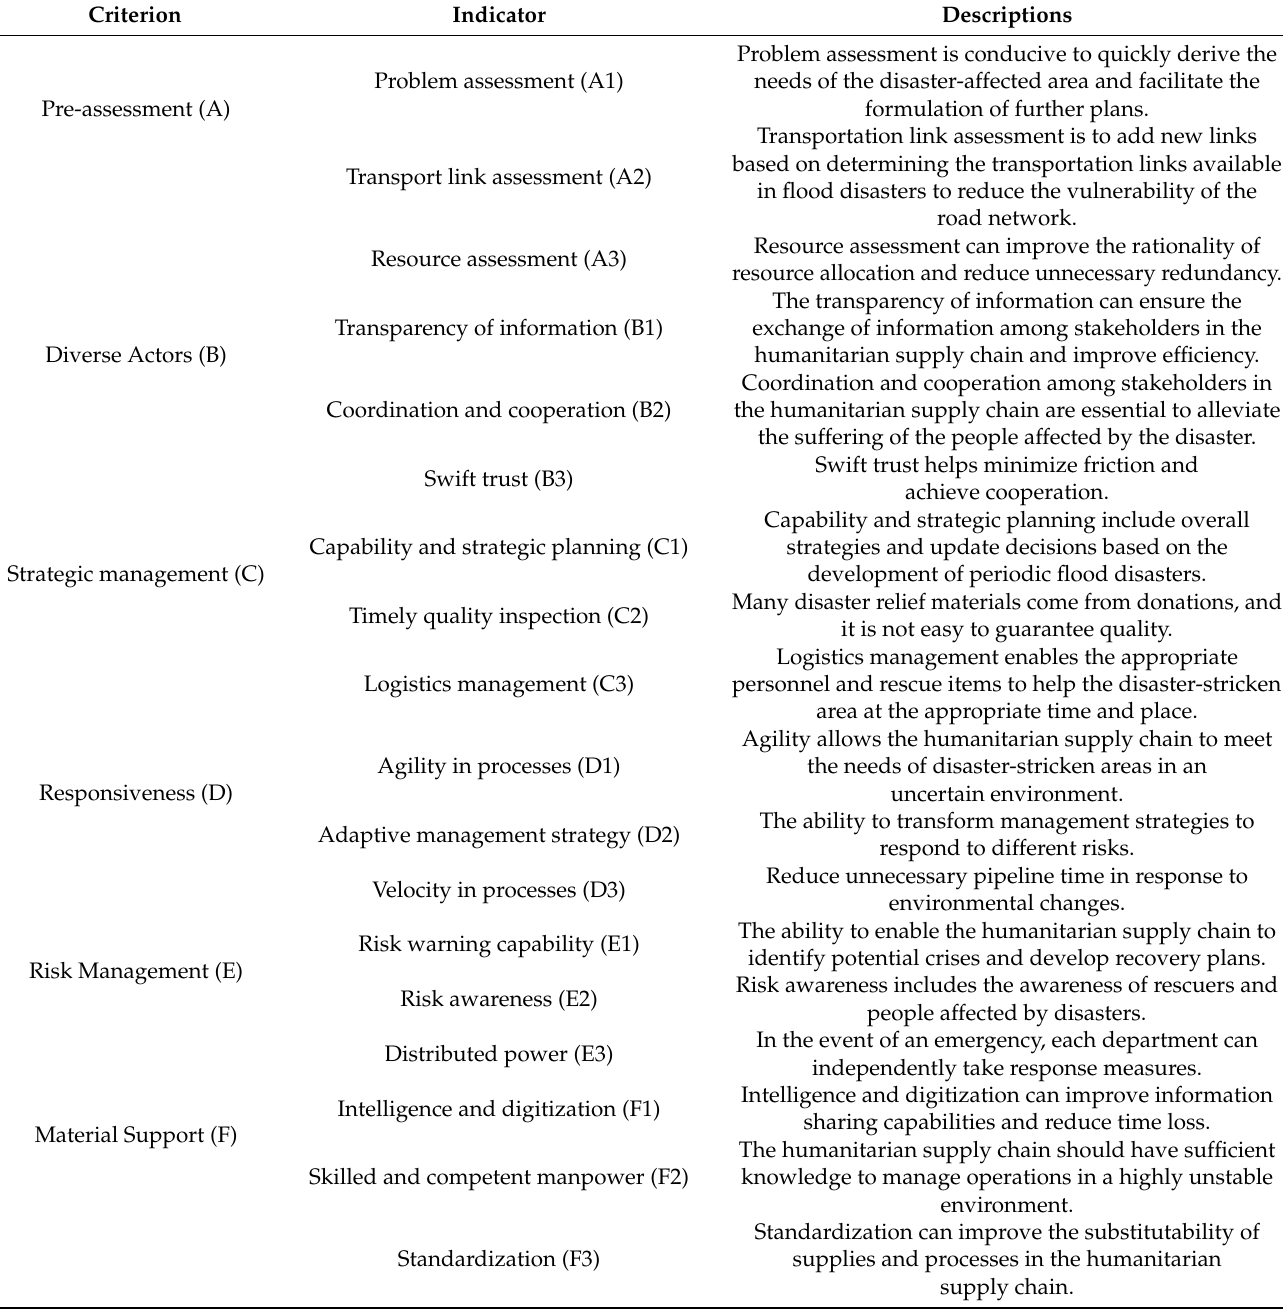
Table 1. Evaluation system of humanitarian supply chain resilience in flood